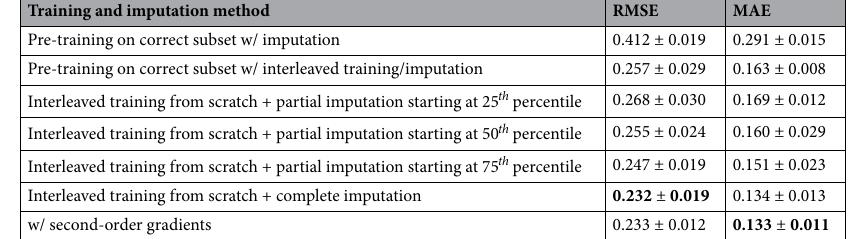
Training and imputation